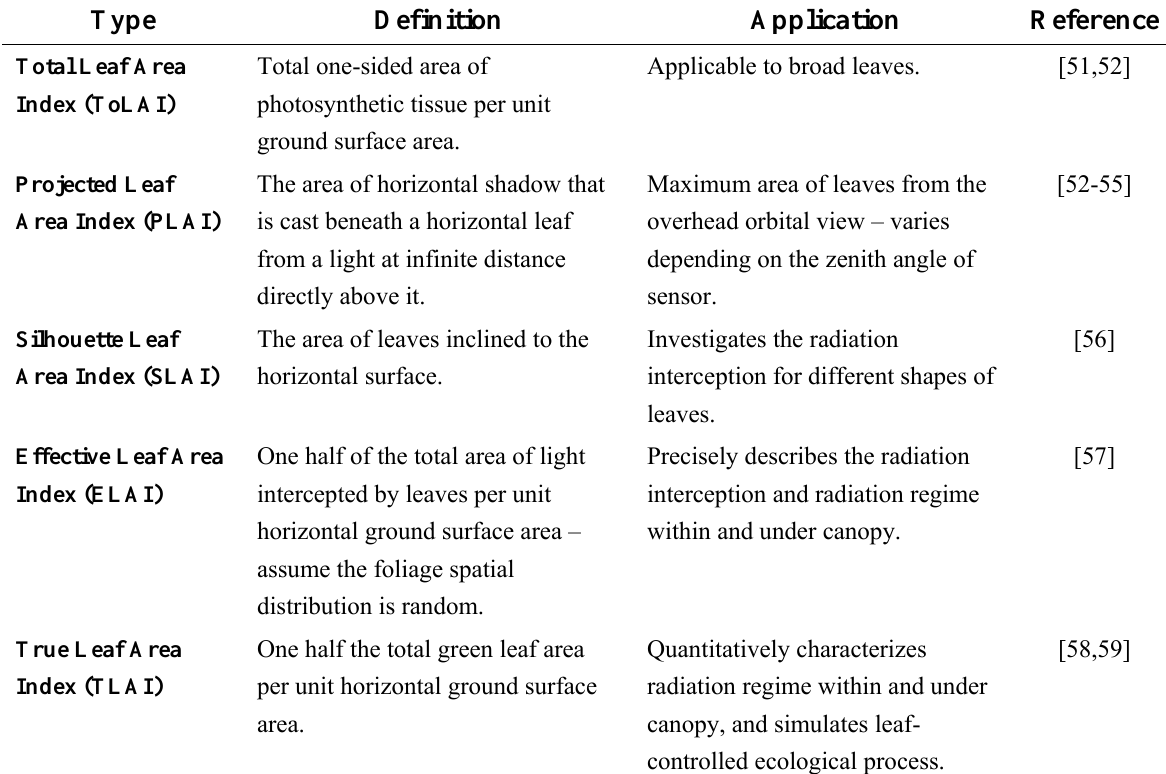
Table 1. Comparison of LAI